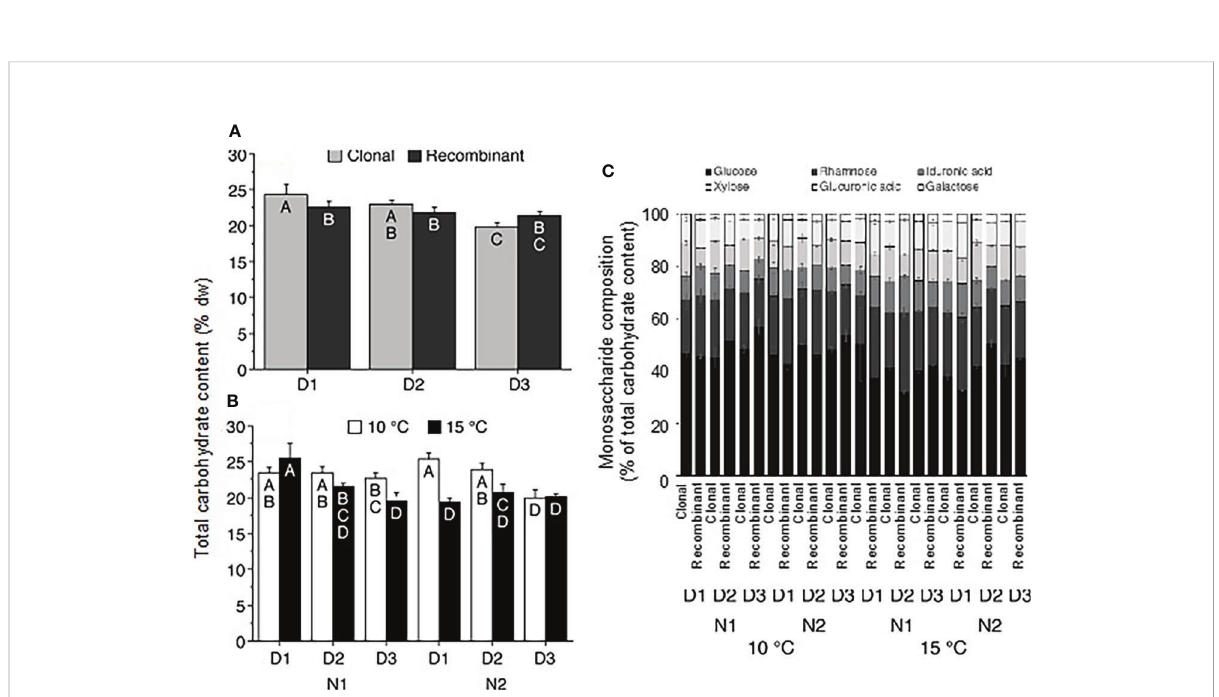
FIGURE 6 Ulva carbohydrate content and composition. Total carbohydrate content (% dw) in Ulva fenestrata (A) clonal and recombinant gametophytes after 12 weeks culture under different densities (D1 = 10 000 swarmers ml -1 , D2 = 5000 swarmers ml -1 and D3 = 500 swarmers ml -1 , for further explanations see text) and (B) under different temperature (10 and 15°C) and nutrient conditions (N1 = PES, N2 = 3xPES, for further explanations see text). Letters within bars denote signi fi cant differences based on the Student Newman Keul´s (SNK) post hoc test. Error bars show SEM (n = 8 in a and n = 4 in b). (C) Distribution of different carbohydrate classes in U. fenestrata clonal and recombinantrecombinand gametophytes exposed to the above conditions. Error bars show SEM (n =